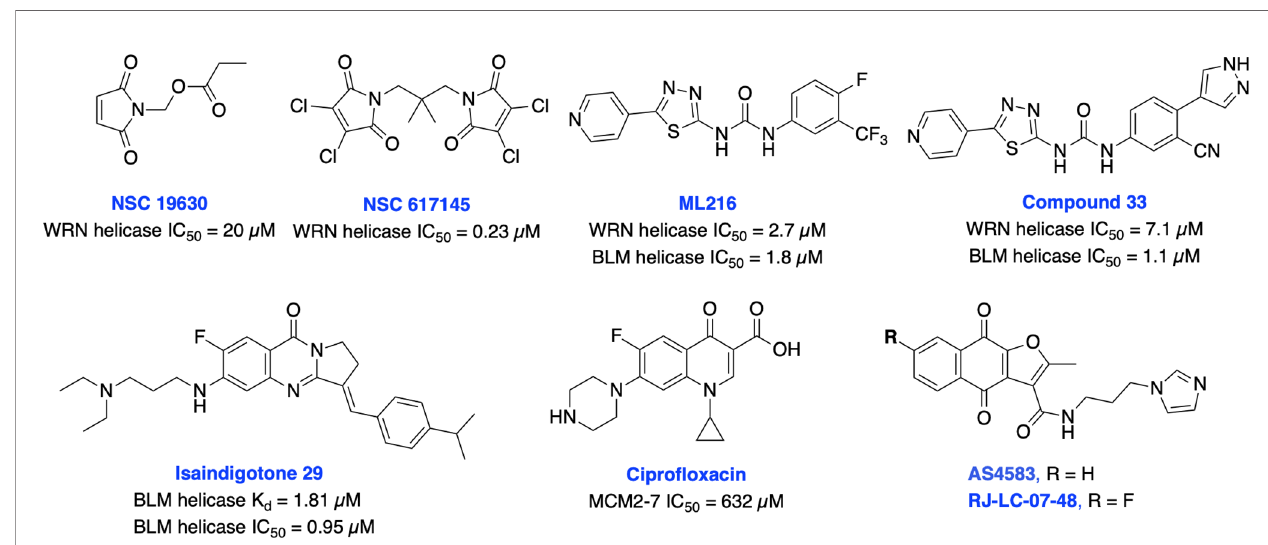
FIGURE 14 | Small molecule inhibitors targeting WRN, BLM and MCM helicases with their respective IC 50